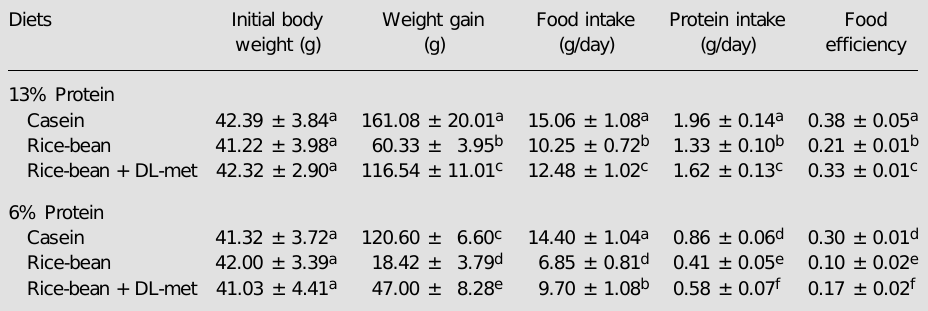
Table 1 - Effect of dietary protein on biological parameters of rats during growth (22-50 days of age). Data are reported as means ± SD (N = 5-18). In any one column, the values of the means marked with different superscripts are significantly different (P<0.05, ANOVA test for two groups). Food efficiency = weight gain/food intake; DL-met =